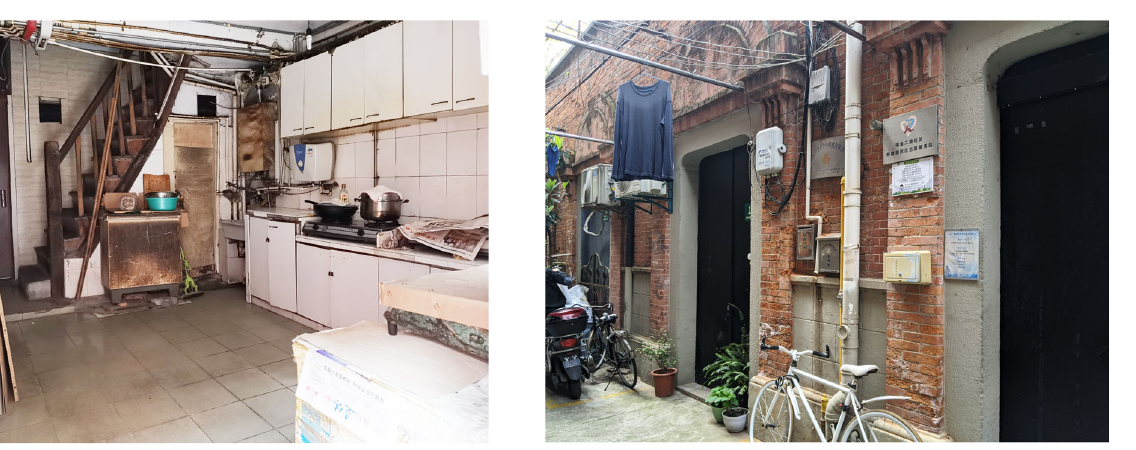
Fig. 6 The kitchen of No. 35, Lane 287, South Shaanxi Road in Bugaoli. After more than 10 years, the white cabinets and consoles, which were equipped in 2007, are still in a relative modern status, compared with the original timber staircases in the room (Source: Kaiyi Zhu, 2018)